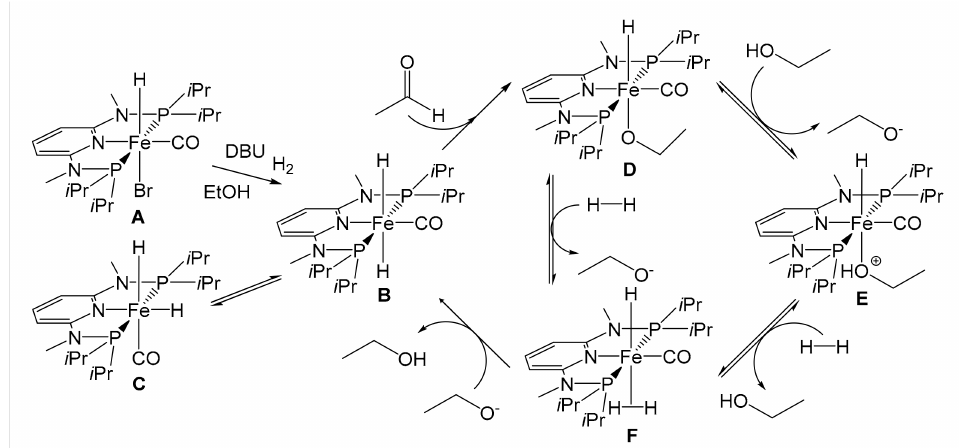
Figure 16. Hydrogenation mechanism of acetaldehyde proposed by Kirchner et al. (DBU = 1,5-diazabiciclo(5.4.0)undec-7- ene)